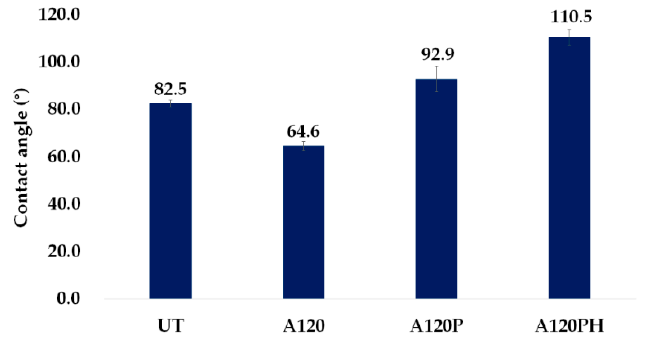
Figure 5. Water contact angle of an untreated sample (UT), a sample treated with an NaOH solution (A120), a sample treated with an NaOH solution and followed by PPy polymerization (A120P), and a sample treated with an NaOH solution and followed by PPy polymerization and hydrophobic coating (A120PH).